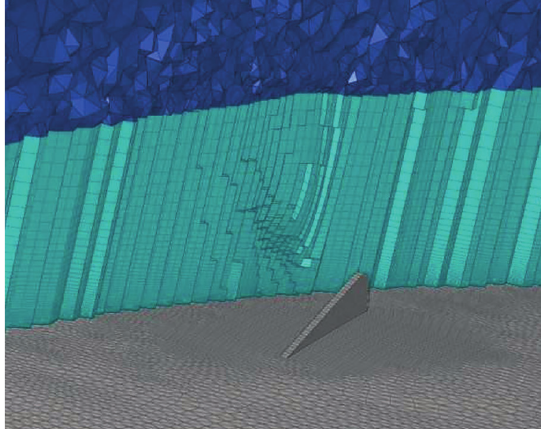
Figure 3. Illustration of the volumetric mesh near the